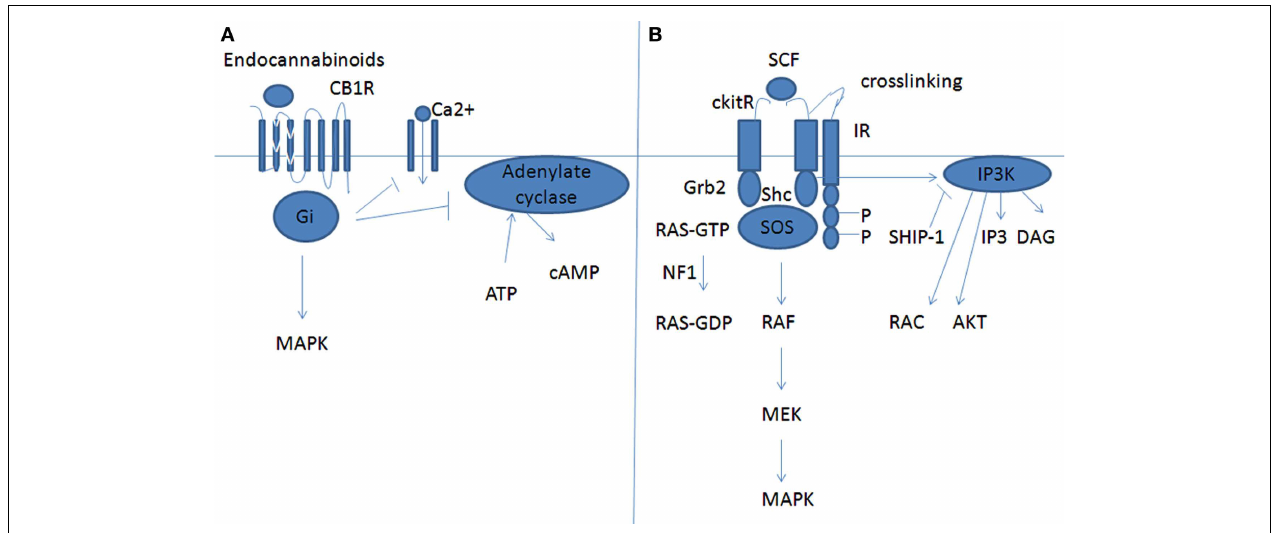
FIGURE 2 | Inhibition of MC maturation by CB1 or by a classical IR receptor. (A) CB1 inhibition effect. (B) Inhibition of c-kit mediated signaling by an inhibitory receptor (IR). Downstream molecules to CB1 or to c-kit cross-linked with the inhibitory receptor (cross-linking is mandatory to inhibitory effect).